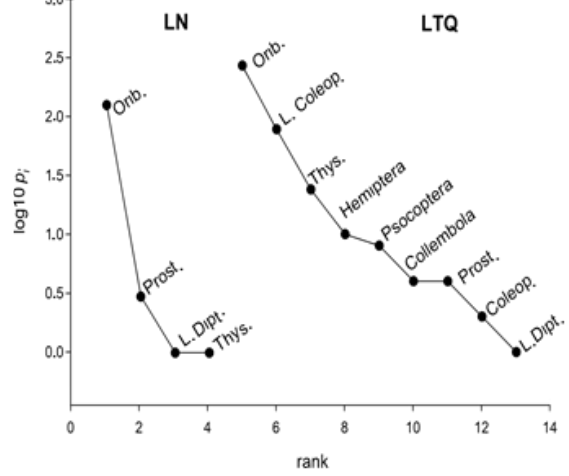
Figure 6. Rank abundance curves of mesofauna taxonomic groups collected in the peatlands associated with Laguna Negra (LN) and Laguna Tres Quebradas (LTQ). Values are plotted on a logarithmic scale of the proportional abundance (p i ) for each taxonomic group. Key to abbreviations: Orib. = Oribatida mites; Coleop. = Coleoptera; L. Coleop. = Coleoptera larvae; Thys. = Thysanoptera; L. Dipt. = Diptera larvae; Prost. = Prostigmata